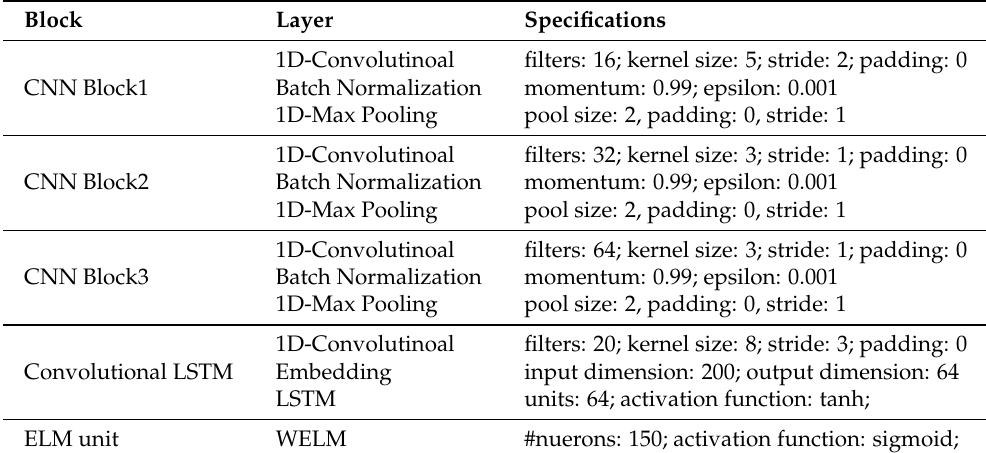
Table 1. Deep learning layer specifications of the diagnosis